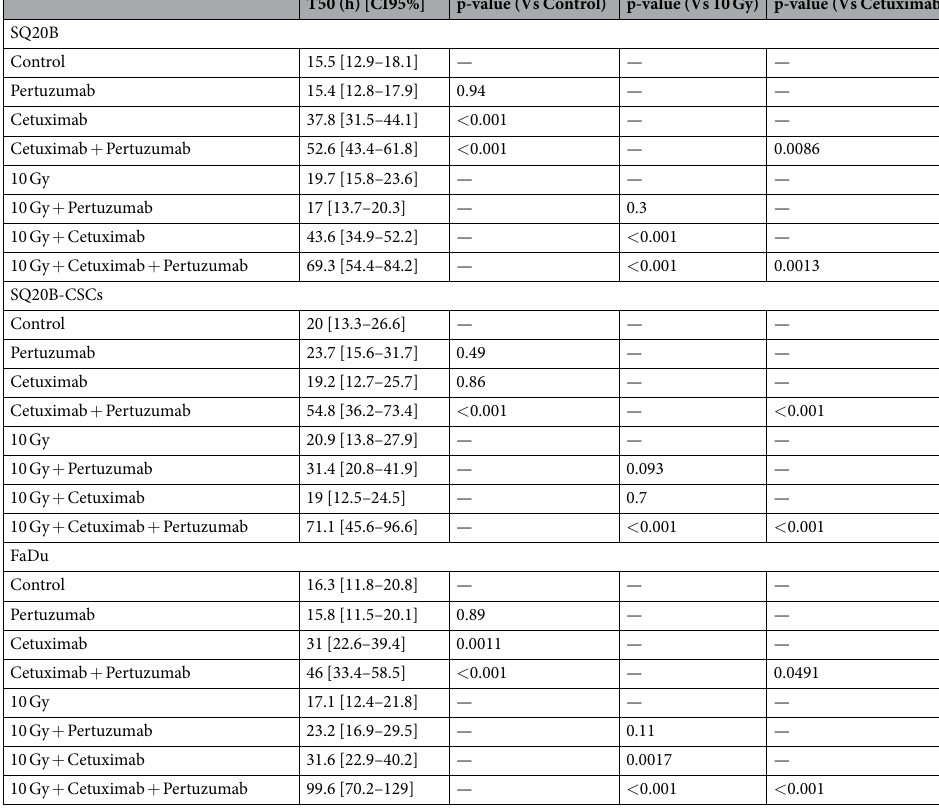
Table 2. Cell migration expressed with time to heal 50% of the wound (T50) and p-values. Leg. T50 (h): time to heal 50% of the wound in hours; CI95%: confidence interval; Vs: versus; Gy: Gray